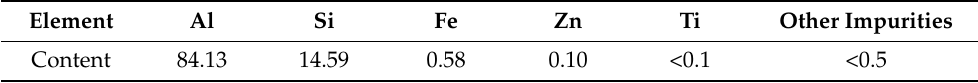
Table 2. Composition of Al–Si alloy